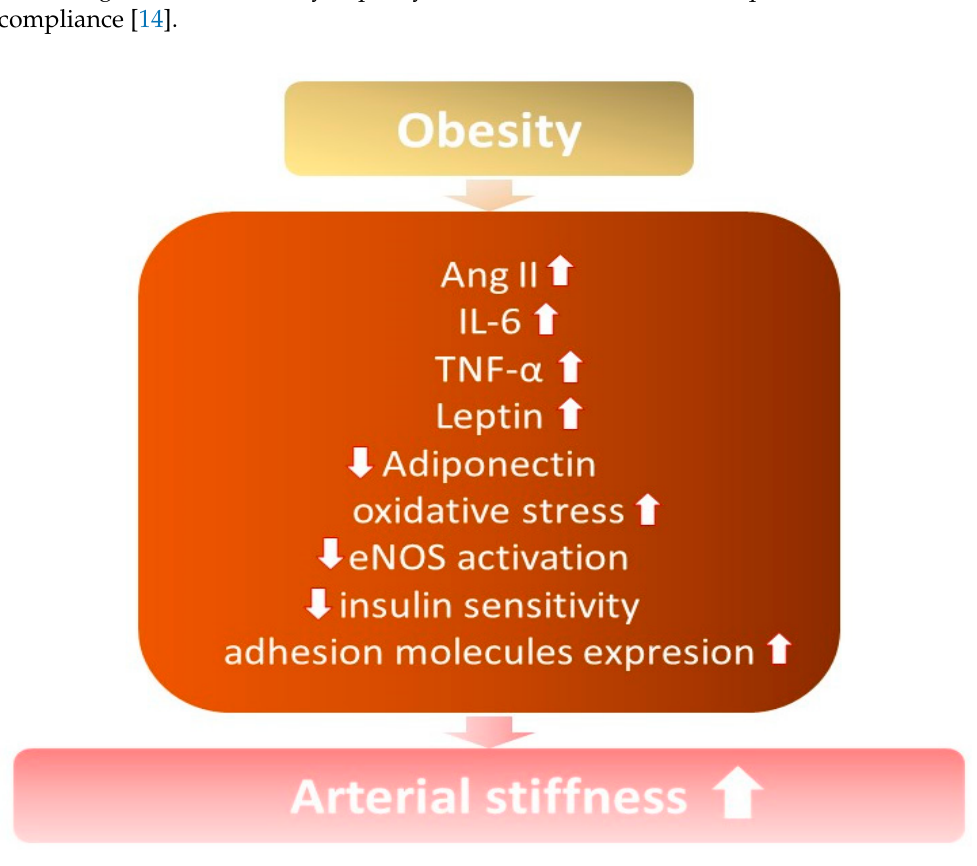
Figure 1. The influence of obesity on the development of increased arterial stiffness. ↓ —decrease; ↑ —increase; Ang II—angiotensin II; IL-6—interleukin 6; TNF- α —tumor necrosis factor; eNOS— endothelial nitric oxide synthase.